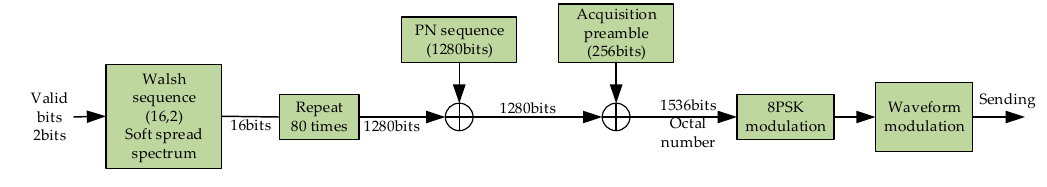
Figure 6. The transmission scheme for burst waveform BW4.